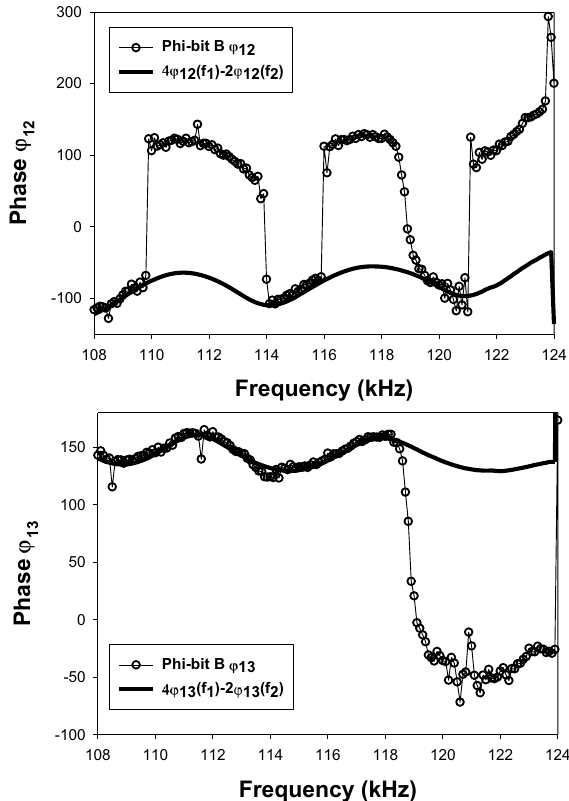
Figure 4. Phases ϕ 12 and ϕ 13 (open circles) measured for the phi-bit “B” defined by the mixed frequency 4 f 1 2 f 2 when f 1 62kHz and the second driving frequency is varied in the interval [70–62 kHz] by − = decreasing increments of 50 Hz. In both graphs the thick solid line corresponds to the linear combination of phases 4 ϕ 12 are the phases of the primary modes at the driving